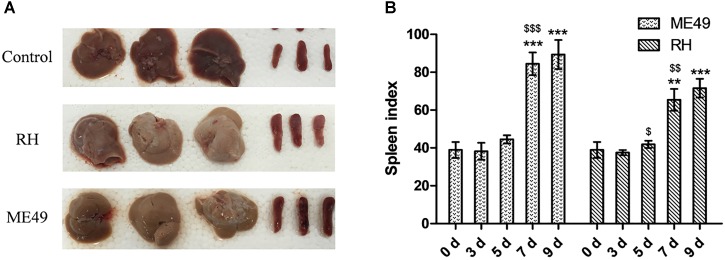
Splenomegaly post-infection. The spleen and liver were observed 7 days post-infection, and the spleen indexes [spleen weight (mg) × 10/body weight (g) × 100%] were calculated. (A) Representative images of spleen and liver from the Control, RH, and ME49 groups. (B) Spleen index of the ME49 and RH groups. The results are representative of three independent experiments with 3–5 mice per group per experiment; data are the means ± SDs. $P < 0.05, ∗∗,$$P < 0.01, ∗∗∗,$$$P < 0.001; ∗indicates comparisons to day 0, $indicates comparisons to the previous time point.